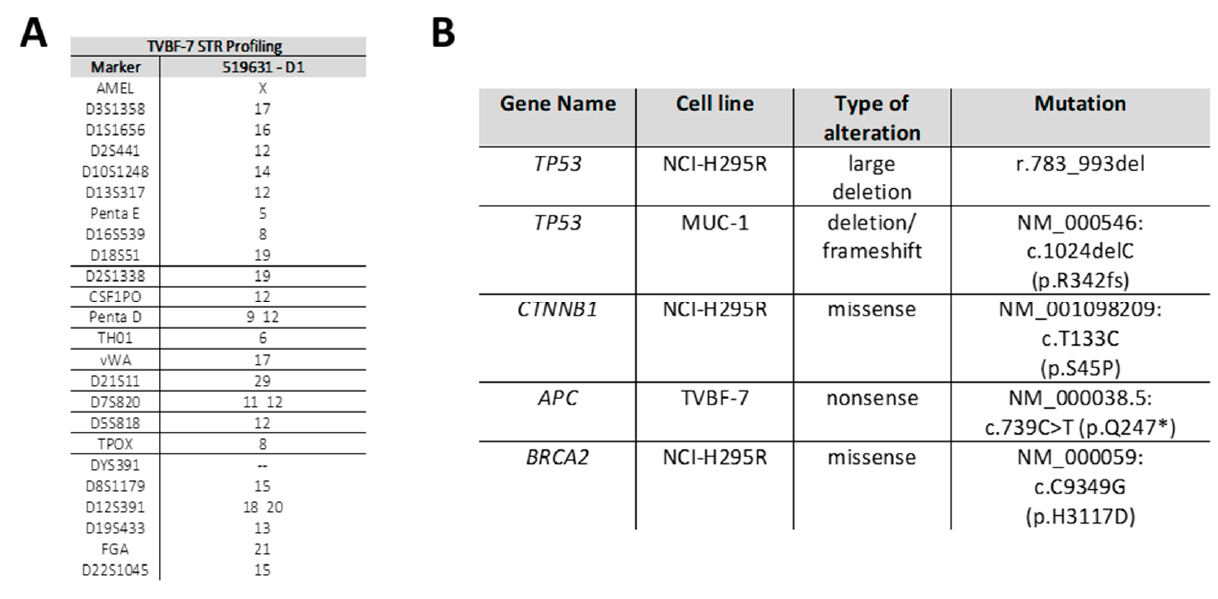
Figure 2. STR profiling of the newly presented TVBF-7 cells ( A ). Most important pathogenic mutations of cancer driver genes as detected by the whole genome sequencing of all three cell lines ( B ).